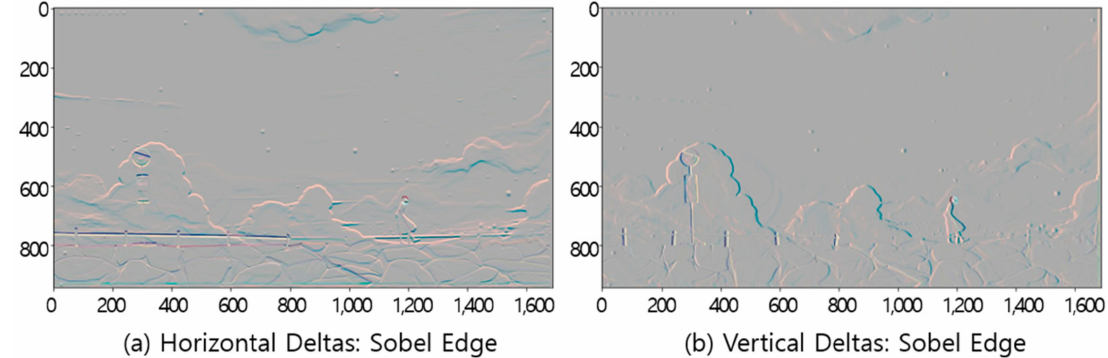
Figure 11. Results of preserving the content features from sobel edge